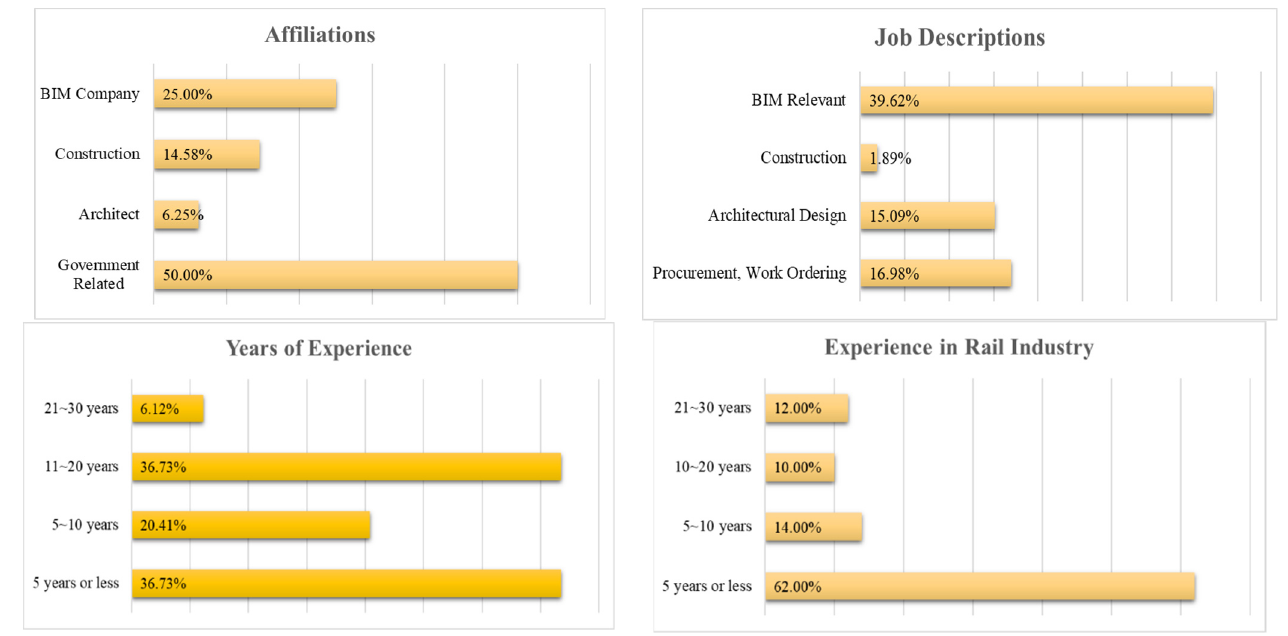
Figure 1. Respondents’ Professional Backgrounds and Years of Experience.